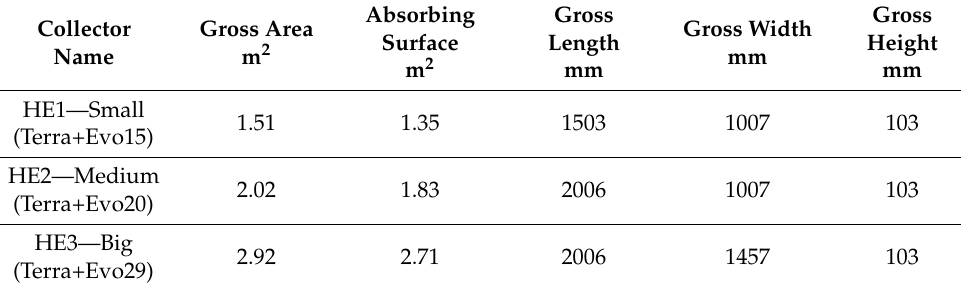
Table 1. Solar collector geometrical details